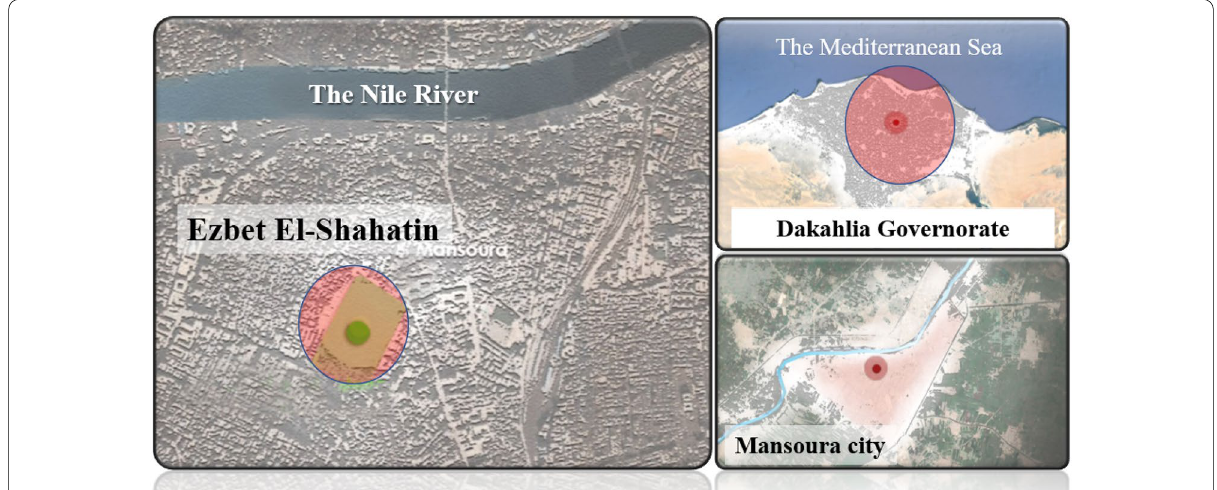
Fig. 3 Ezbet El‑Shahatin Site